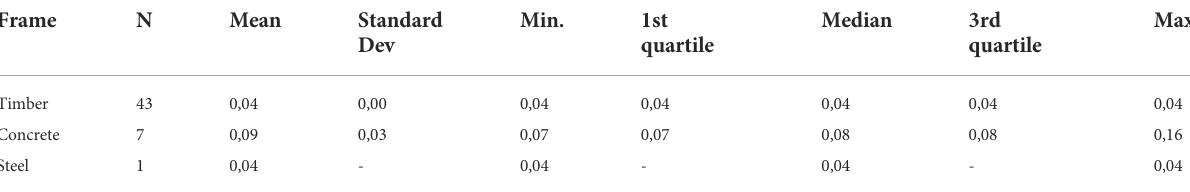
TABLE 5 An overview of GJ/m 2 demolition energy of buildings.